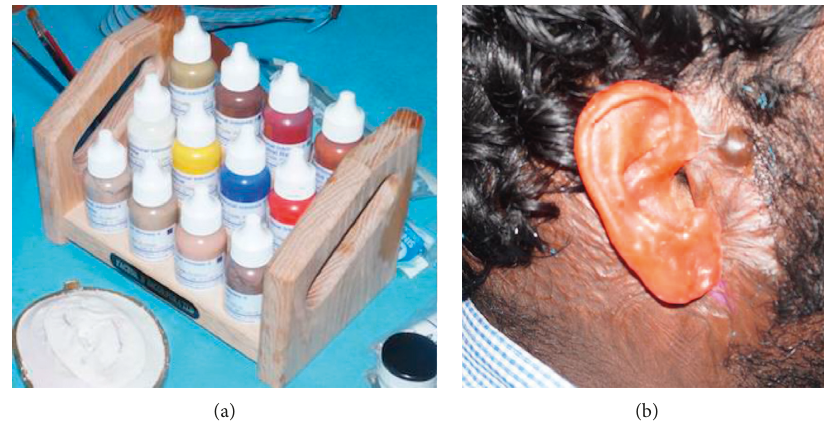
Figure 5: Colour matching using intrinsic factor II stain.